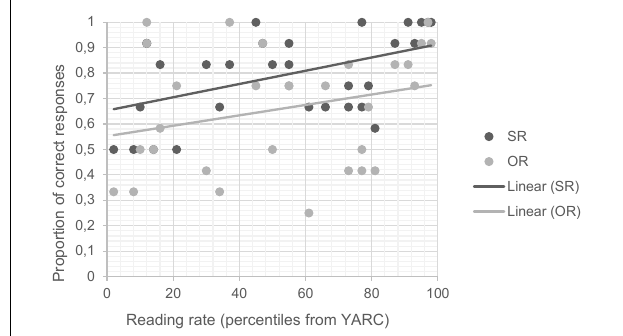
FIGURE 3 | Scatterplot reading – type in the mismatch subset. SR, subject relative; OR, object relatives; YARC, York assessment of reading and